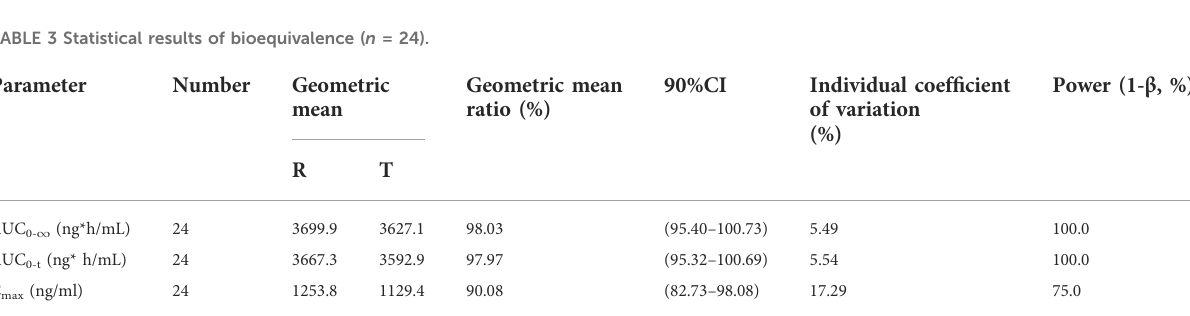
TABLE 3 Statistical results of bioequivalence ( n =